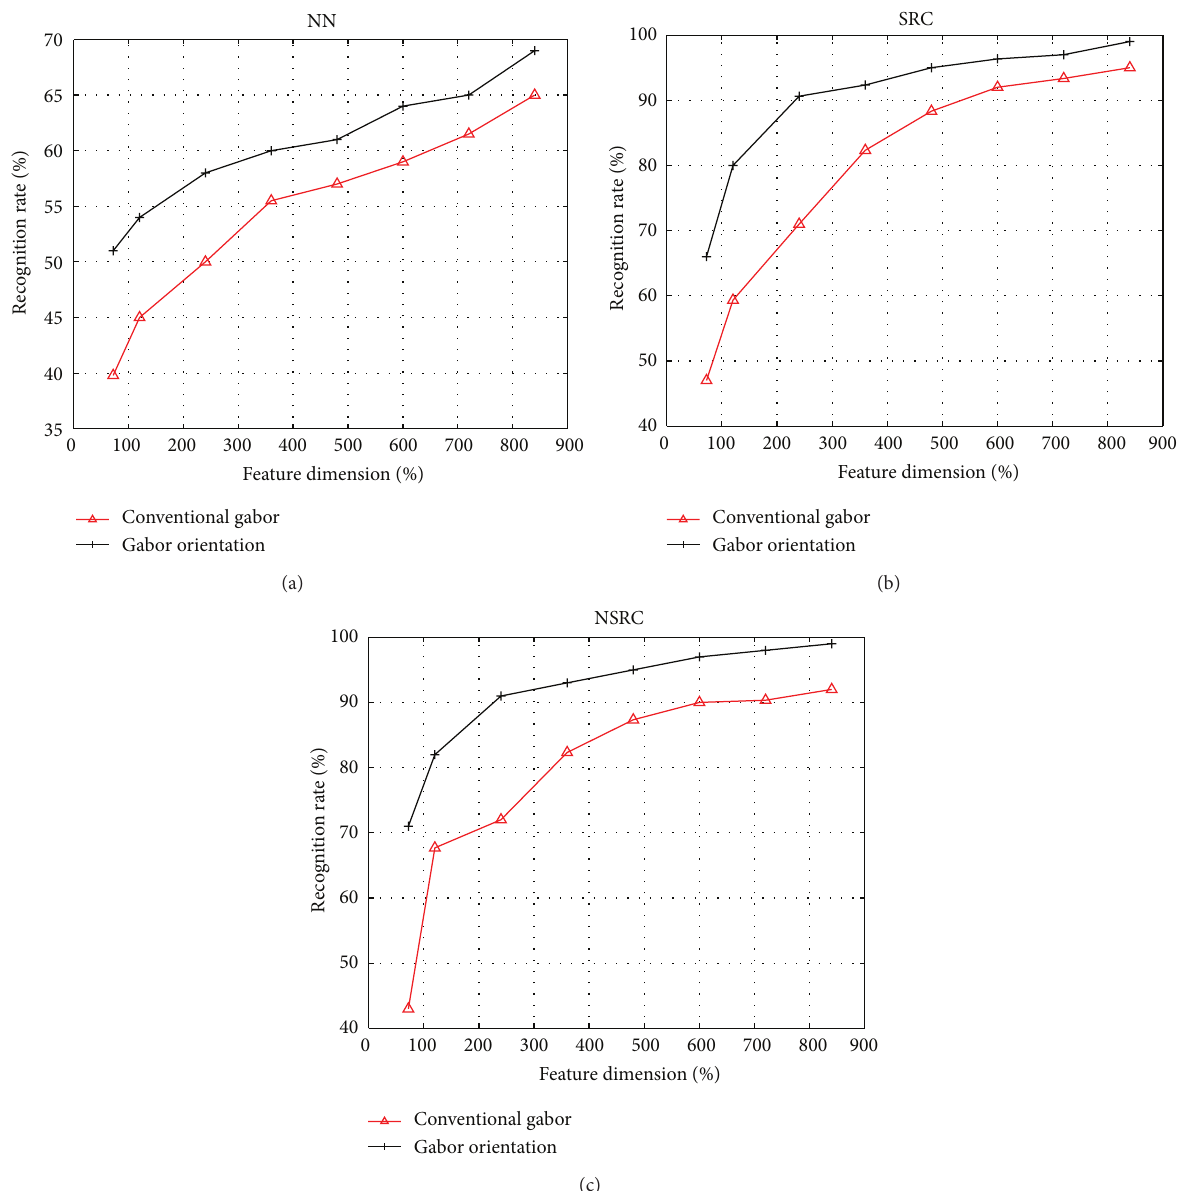
Figure 4: Recognition rates for our proposed Gabor orientation features and conventional Gabor features using various classifiers: (a) NN, (b) SRC, and (c) NSRC (our proposed